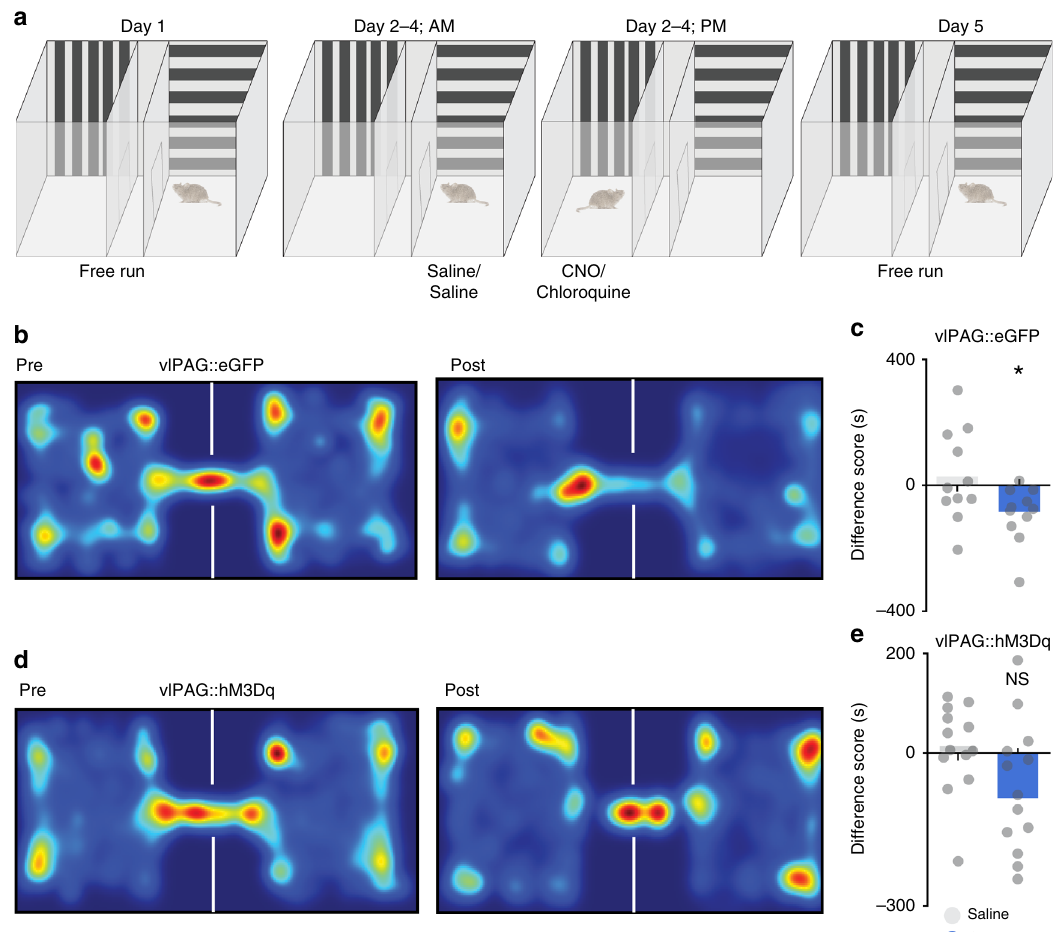
Fig. 3 Chemogenetic activation of vlPAG neurons can block aversive component of itch. a Schematic of conditioned place aversion experimental design in AAV8 hM3Dq – mCherry and AAV8 – eGFP injected animals. Mice received treatment with either i.p. saline or CNO 90 min before pairing the mice in the chambers with saline or chloroquine, respectively. b Representative heat map showing spatial location of a control mouse injected with AAV8 – EGFP, pre and post chloroquine conditioning. c After CNO (0.5 mg/kg, i.p) administration in vlPAG::eGFP mice, difference scores indicate mice spent signi fi cantly less time in the chloroquine paired chamber compared to saline paired chamber ( N = 13, t test, t = 2.128 df = 24, * P = 0.0219). d Representative heat map showing spatial location of a mouse injected with AAV8 – hM3Dq, pre and post chloroquine conditioning. e Activation of vlPAG::hM3Dq neurons with CNO (0.5 mg/kg, i.p) before mice were conditioned with chloroquine resulted in disruption of CPA to chloroquine ( N = 13, t test, t = 0.01788 df = 24 P = 0.9859). All values are mean ± SEM. Source data are available as a Source Data fi